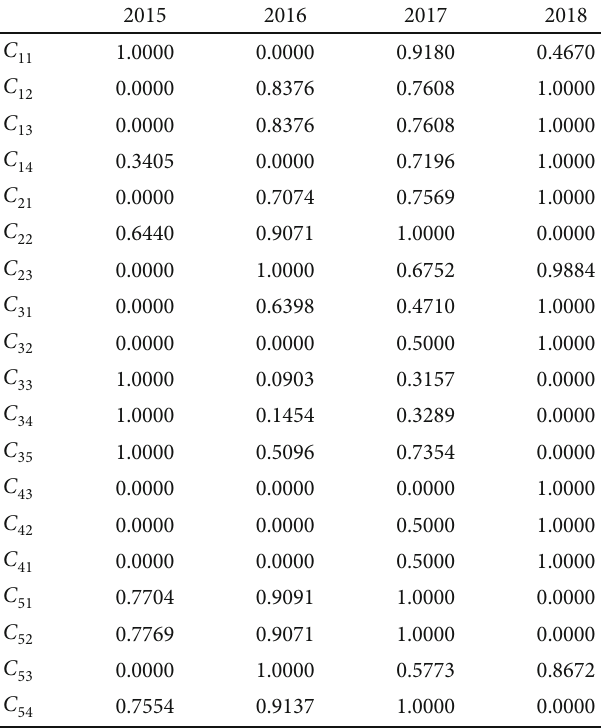
Table 14: Decision matrix of standardized evaluation